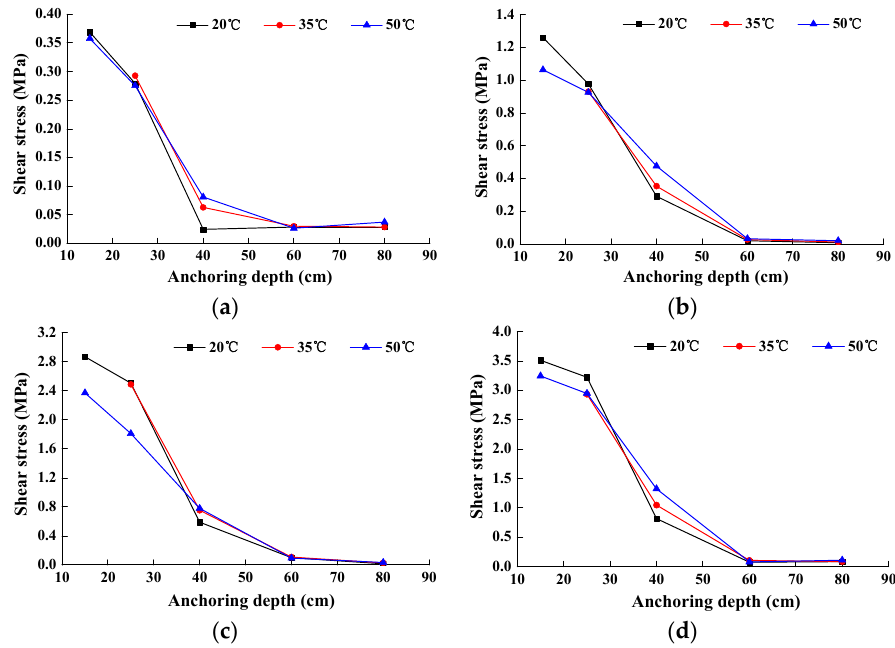
Figure 10. The distribution diagrams of shear stress under different Tensile force. ( a ) Tensile force is 10 kN. ( b ) Tensile force is 30 kN. ( c ) Tensile force is 70 kN. ( d ) Tensile force is 90 kN.